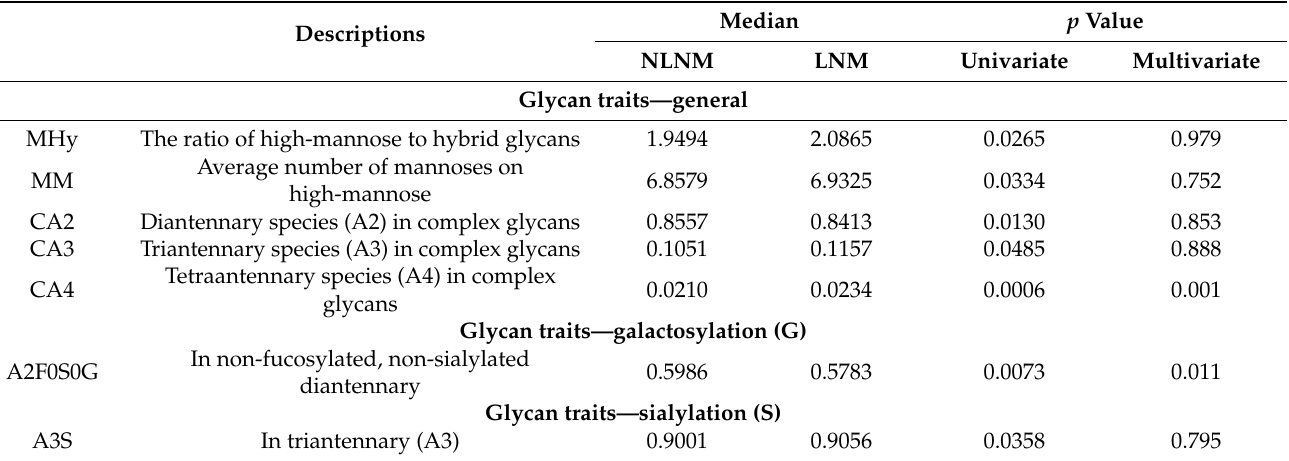
Table 3. The univariate and multivariate analysis of differentially expressed derived N -glycan traits between papillary thyroid microcarcinoma (PTMC) with lymph node metastasis (LNM) and PTMC with non-LNM